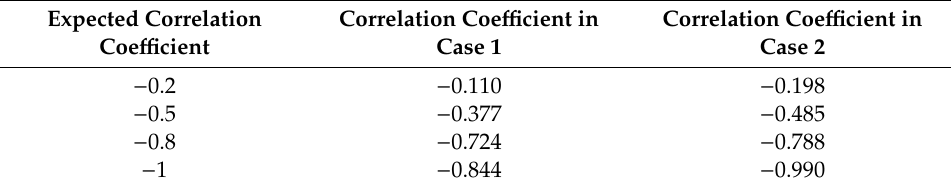
Table 1. Correlated samples in Case 1 and Case 2.